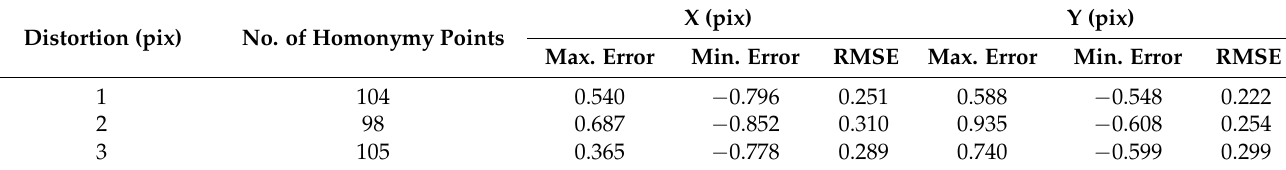
Table 15. Stitching error of EA-unstable-3 (left-middle image).